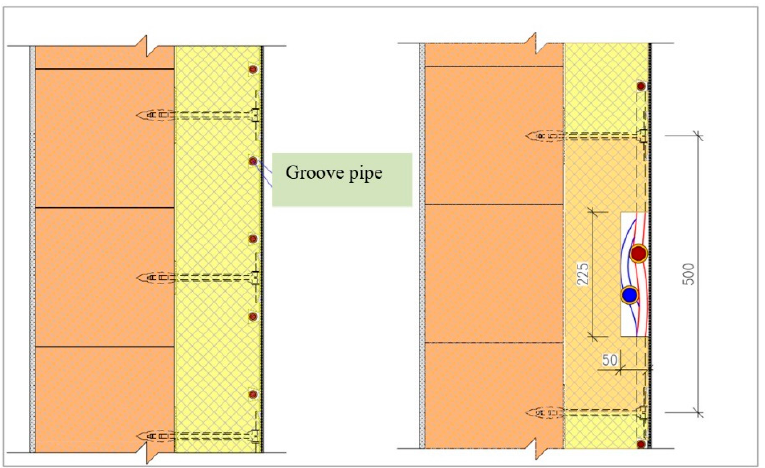
Figure 19. Application of the contact insulation system with a register collecting solar energy or energy of the surrounding environment, in combination with heat pump [23].